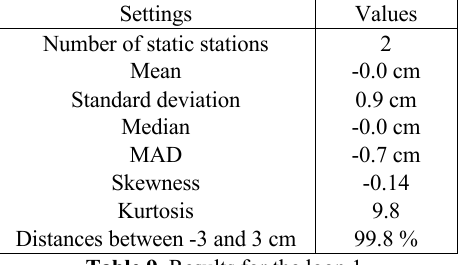
Figure 10. Trajectory of the MMS (in blue), and SLS stations (red triangles)